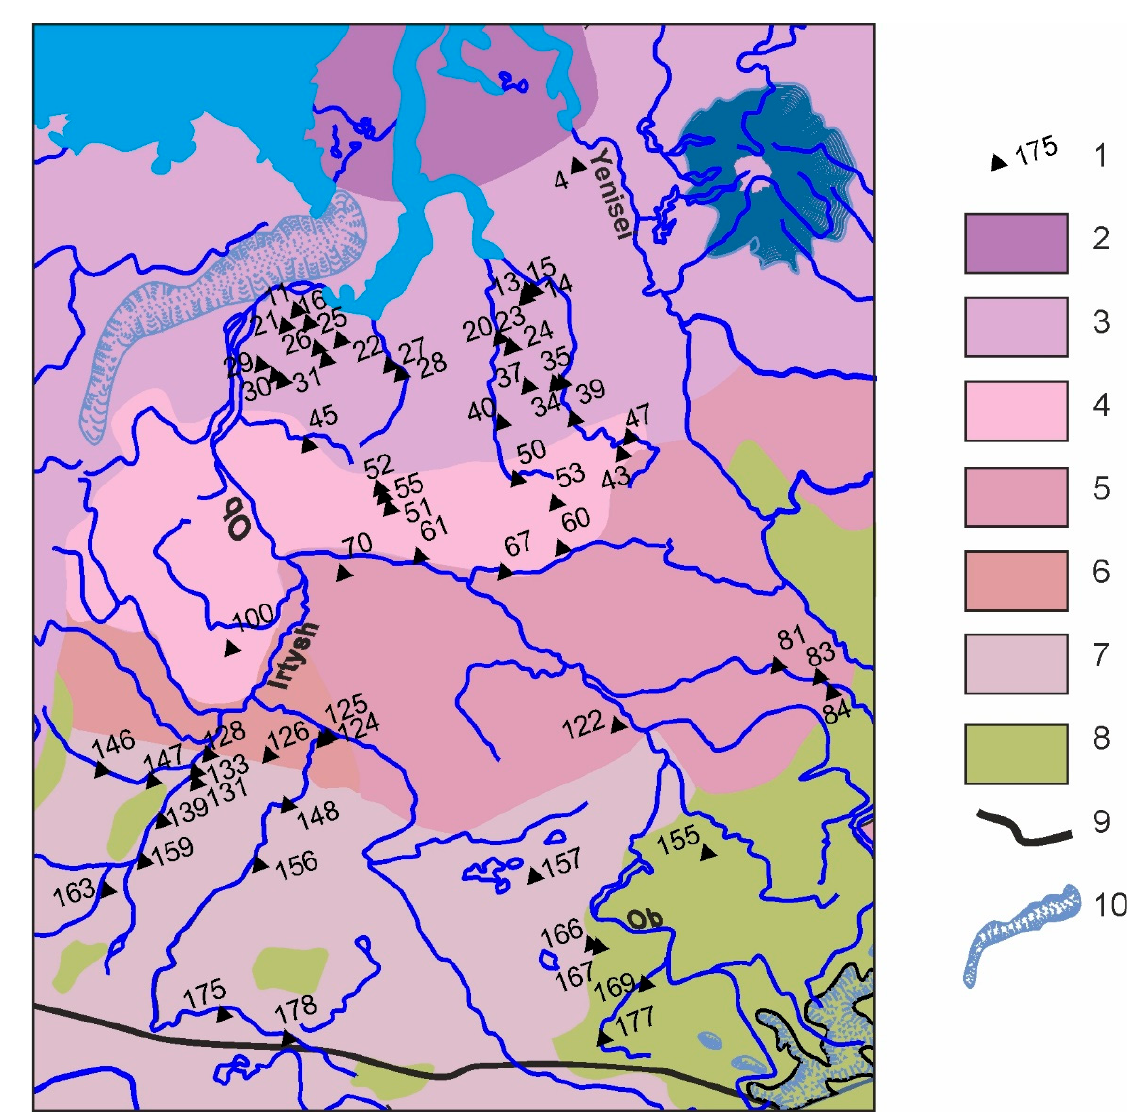
Figure 1. The distribution of well-preserved fragments of large paleochannels of the Pleniglacial age in the West Siberian Plain. 1—data points (Table S1). Vegetation during the Pleniglacial (adapted from [22]); 2—arctic desert; 3—moss and dwarf shrub tundra; locally with birch and spruce open woodlands; 4—spruce and birch open woodlands; 5—meadow steppe with birch and spruce forests and tundra communities; 6—meadow steppe in combination with pine forests; 7—sagebrush–grass and sagebrush–saltwort steppes; 8—pine, spruce and birch forests with steppe communities; 9— southern boundary of continuous permafrost; 10—mountain glaciers.